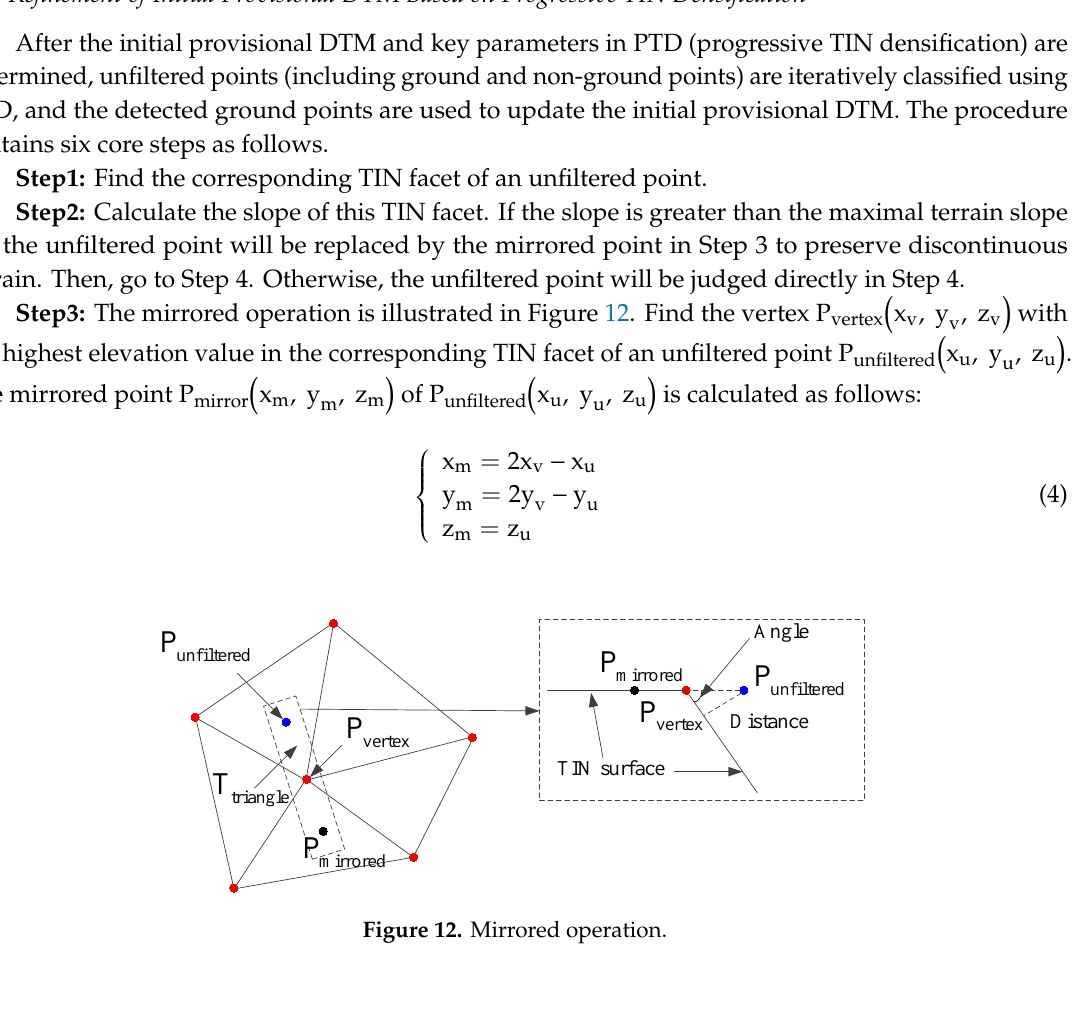
Figure 11. Simple demonstration of the maximum distance threshold setting.